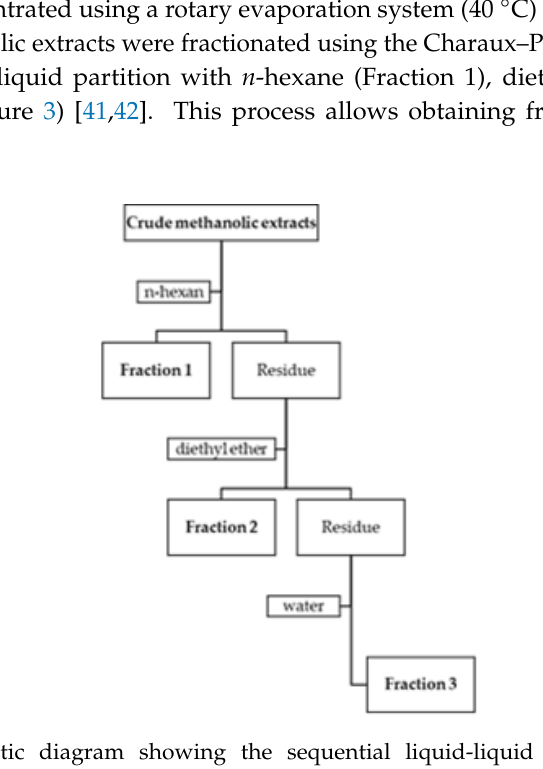
Figure 3. Schematic diagram showing the sequential liquid-liquid partition of the crude methanolic